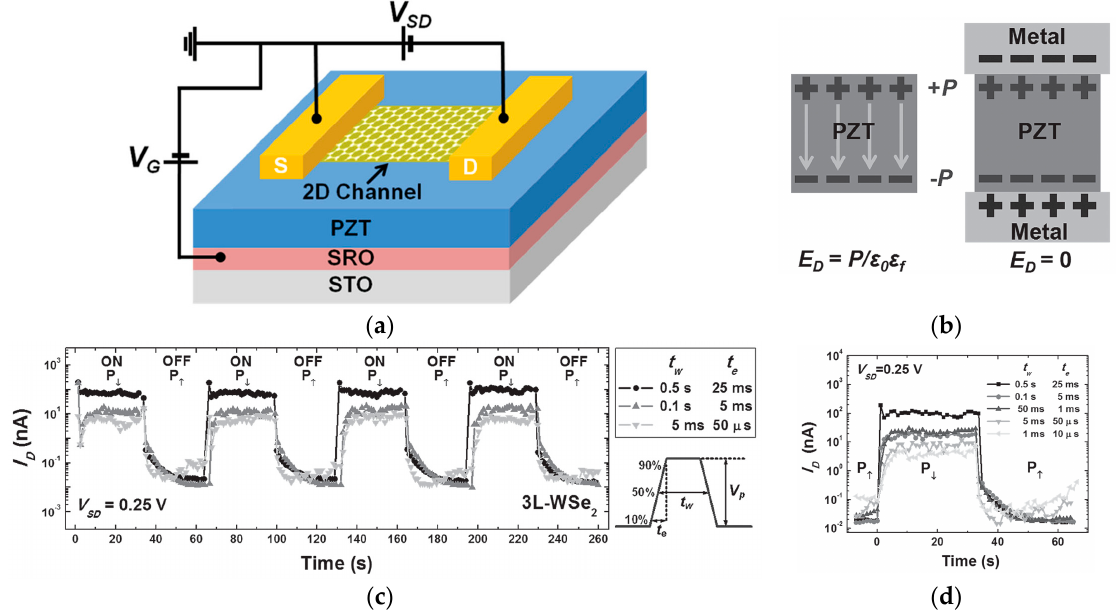
Figure 7. Nonvolatile memory produced by inorganic FeFETs. ( a ) Device schematic of the 2D TMD/PZT heterostructure; ( b ) E D in an isolated PZT thin film and in a sandwich structure with metal electrodes; ( c ) I D versus time curves of on and off states with different sets of voltage pulse parameters: peak voltage ( V P ), width ( t w ), and edge ( t e ); ( d ) A series of relaxation curves immediately after pulsed gating at on (down-polarized, P ↓ ) states and off (up-polarized, P ↑ ) states at various t w and t e (Changhyun Ko et al. [96]).